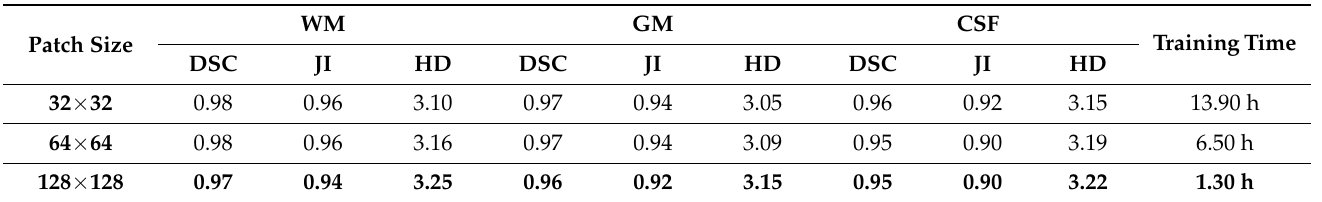
Table 4. Segmentation accuracy and training time (hours) for the proposed method under different input-patch sizes using the axial plane on the OASIS dataset.